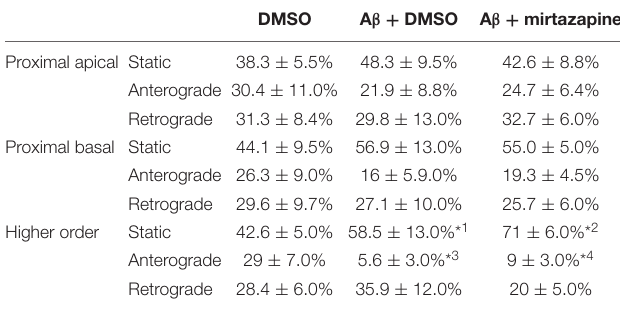
TABLE 1 | Summary of the pGOLT dynamics in unstimulated cultures.